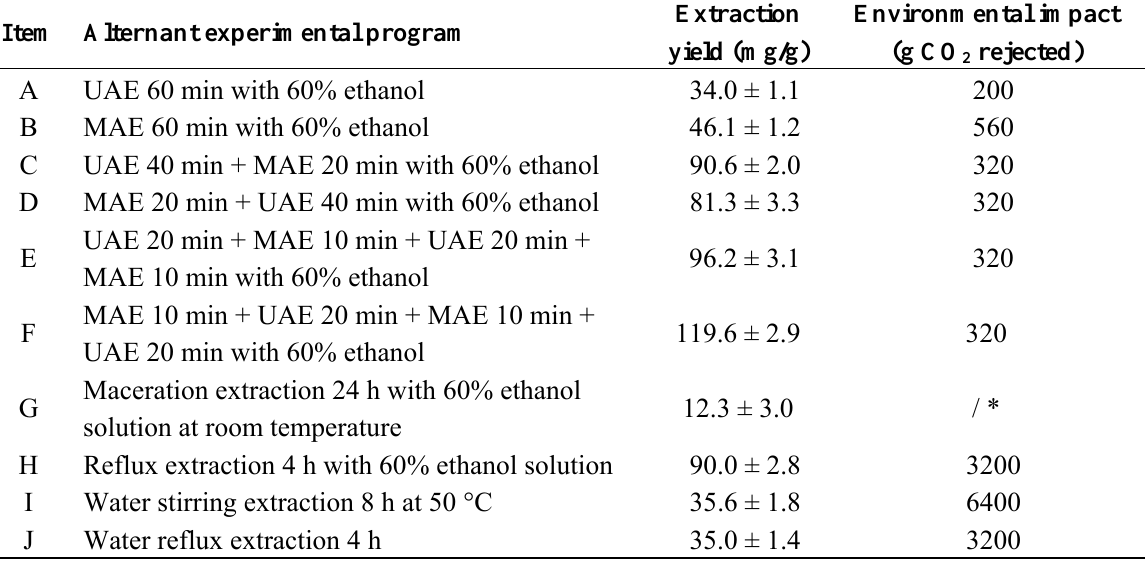
Table 1. Experimental program of ultrasound assisted alternant extraction method (UAE), microwave assisted alternant extraction method (MAE) and comparison extraction methods.